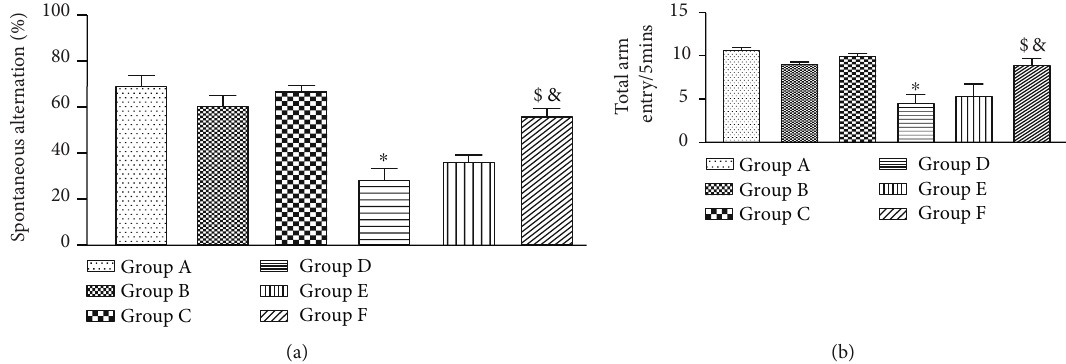
Figure 8: (a) Y-maze (spontaneous alternation) for nondiabetic groups administered with vehicle (A), HAART (B), and HAART-AgNPs (C) and diabetic groups administered with vehicle (D), HAART (E), and HAART-AgNPs, a =(a). ∗ p < 0 : 05 vs. group A (nondiabetic control); & p < 0 : 05 vs. group D (diabetic control); $ p < 0 : 05 vs. group E (diabetic+HAART). (b) Y-maze (locomotion) for nondiabetic groups and diabetic groups. Nondiabetic groups administered with vehicle (A), HAART (B), and HAART-AgNPs (C) and diabetic groups administered with vehicle (D), HAART (E), and HAART-AgNPs, b =Figure 8(b). Data are expressed as mean ± SEM ( n = 8 ); ∗ p < 0 : 05 vs. group A (nondiabetic control), & p < 0 : 05 vs. group D (diabetic control), $ p < 0 : 05 vs. group E